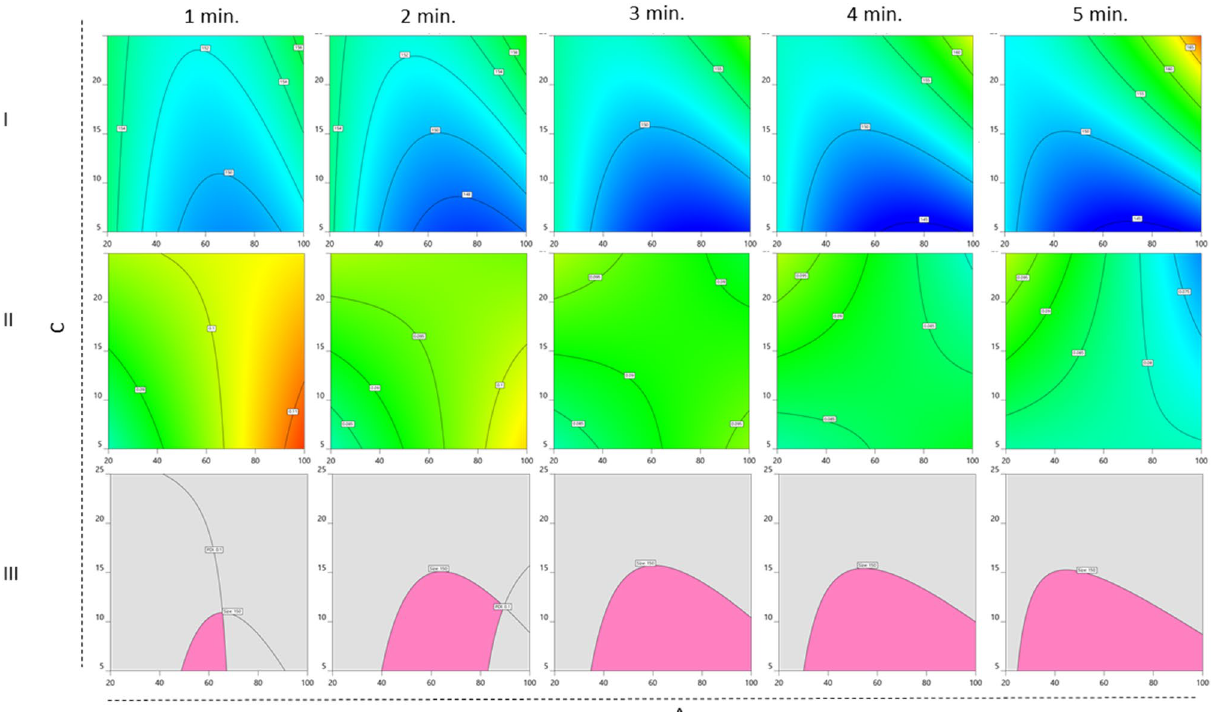
Figure 7. Contour plots generated in DesignExpert depicting A (amplitude, %, x-axis) versus C (temperature, °C, y-axis) at fixed B (duration, min., columns). Size (row I) and PDI (row II) responses at fixed variable C as indicated at the top of each column. Colors from warm to cool indicate values from high to low. Row III depicts overlay plots of the two responses where the criteria of size < 150 nm and PDI < 0.1 are fulfilled at each